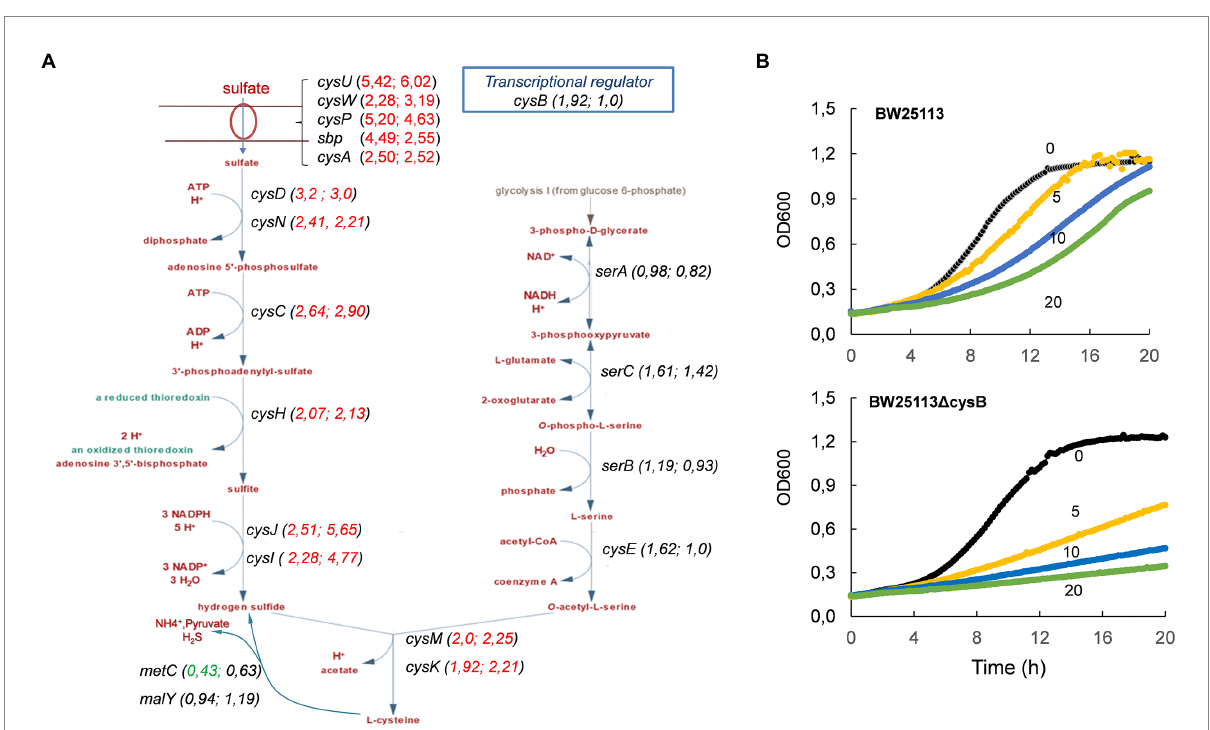
FIGURE 9 Genes encoding sulfate uptake and assimilation are upregulated in MG1655 (WT) and MG1655 Δ thrL strains during growth in M9 medium buffered at pH 7.0 with 100 mM MOPS contained 2% (w/v) glucose in the presence of 10 mM L-homoserine. In (A) is shown the change in gene expression (in parentheses) in the metabolic map, starting with sulfate transport to hydrogen sulphide condensation with O-acetyl serine to produce cysteine. The first value in parentheses corresponds to that of WT and the second to Δ thrL mutant strain. In (B) is shown that the loss of cysB in strain BW25113 enhance its sensitivity to L-homoserine. Concentration of L-homoserine added to the medium is reported on the growth